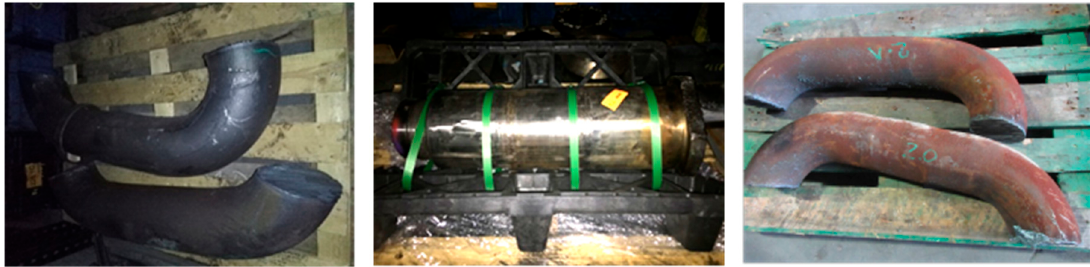
Figure 1. Left to right, samples A, B and C. Sample A : Two R4 chain link halves; Sample B : R4 Chain accessory; Sample C : Two R5 chain link halves. Table 2. Identification of the three high ‐ strength materials tested in the study.